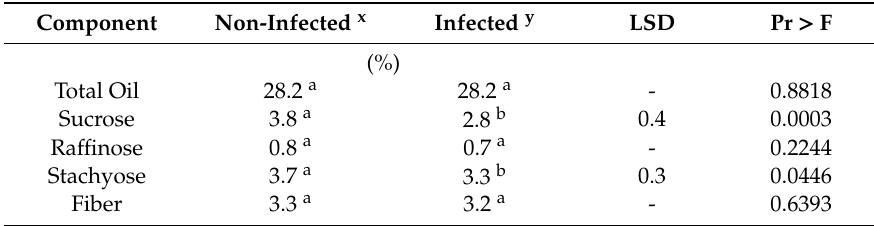
Table 2. The comparison of non-infected (non-symptomatic) compared to infected soybean seed as it influenced seed total oil, sugars, and fiber content. The field experiment was conducted in 2019 at the Delta Research and Extension Center in Stoneville, MS.